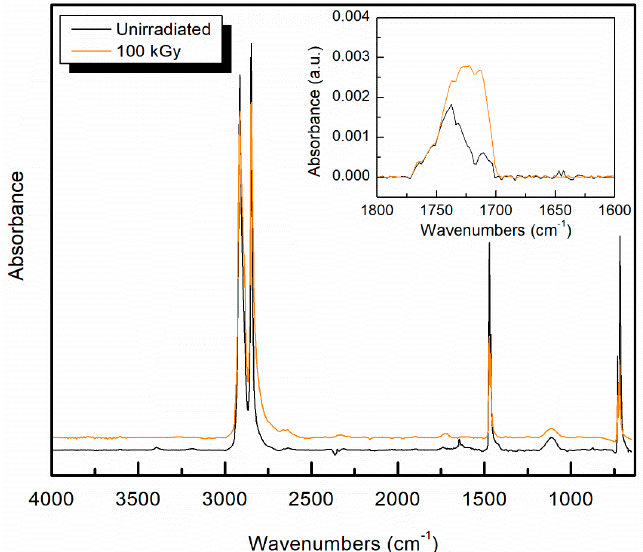
Figure 4. The complete FTIR spectra of unirradiated and gamma irradiated UHMMPE fibers at 100 kGy; inset shows the region in which oxidation would be expected; the two IR spectra have been slightly offset to allow a clearer presentation.